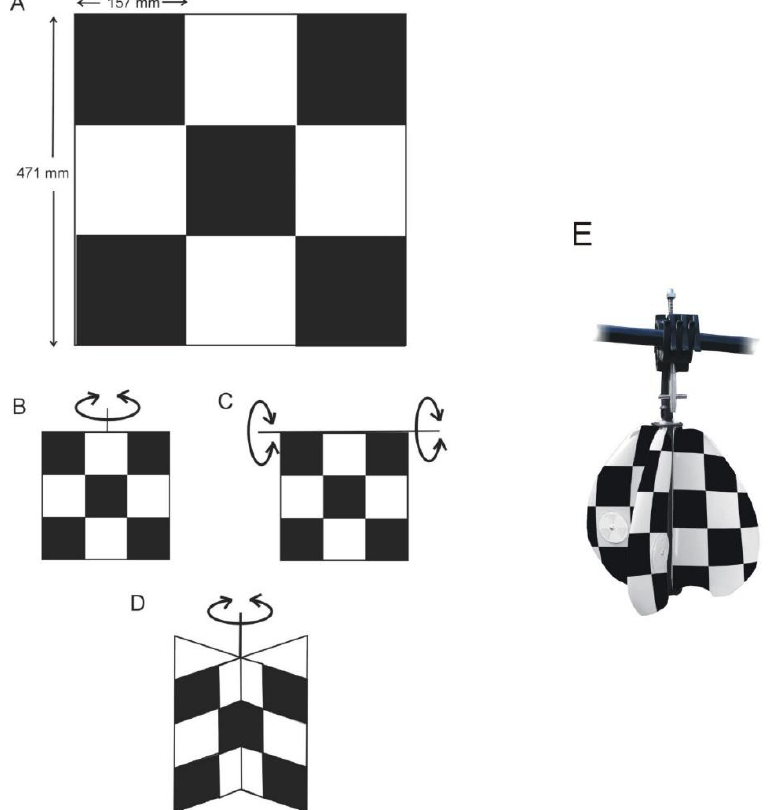
Figure 4. ( A ), essential design elements of a worst-case bird diverter based upon the vision of a Canada Goose. ( B – D ), depicts possible ways that the checkerboard pattern could be made to oscillate or rotate. The dimensions given in A indicate the physical size that should ensure a flying Canada Goose would be able to detect the diverter at a sufficient distance to change its flight trajectory and avoid the obstacle. ( E ), a possible interpretation of how the design features could be combined in a device.